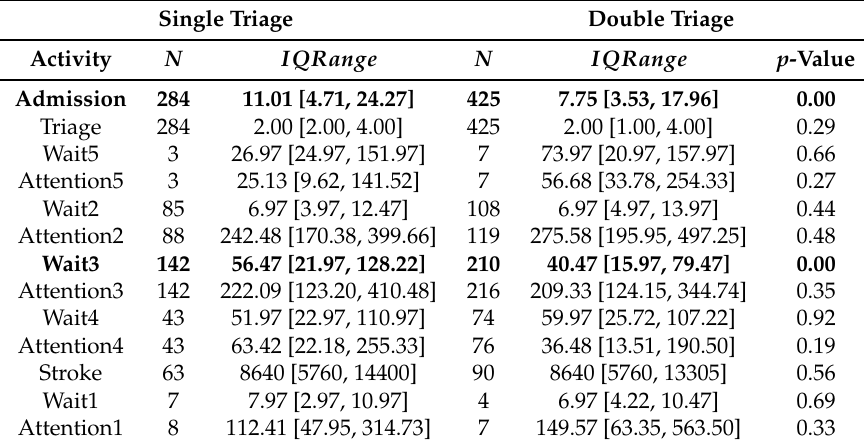
Table 2. Sample size and descriptive statistics for the time (in minutes) for Ordinary and Stroke Unit Admission Nodes. Bold rows are for statistically significant differences between groups.